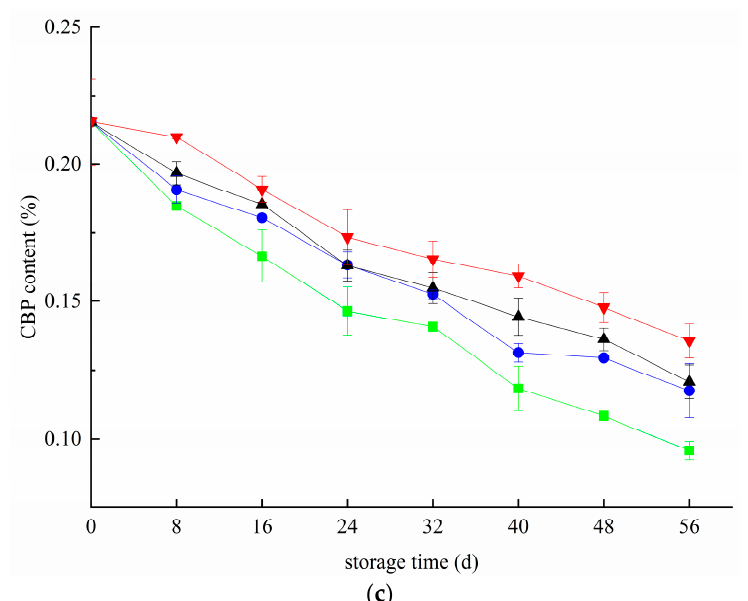
Figure 2. Effect of pectin substance in blueberry under different treatments ( a – c ). a: Changes in water-soluble pectin content in blueberry; b: Changes in ionic pectin content in blueberry; c: Changes in covalent pectin content in blueberries. ■ : control; ● : T; ▲ : Z: ▼ : T plus Z.